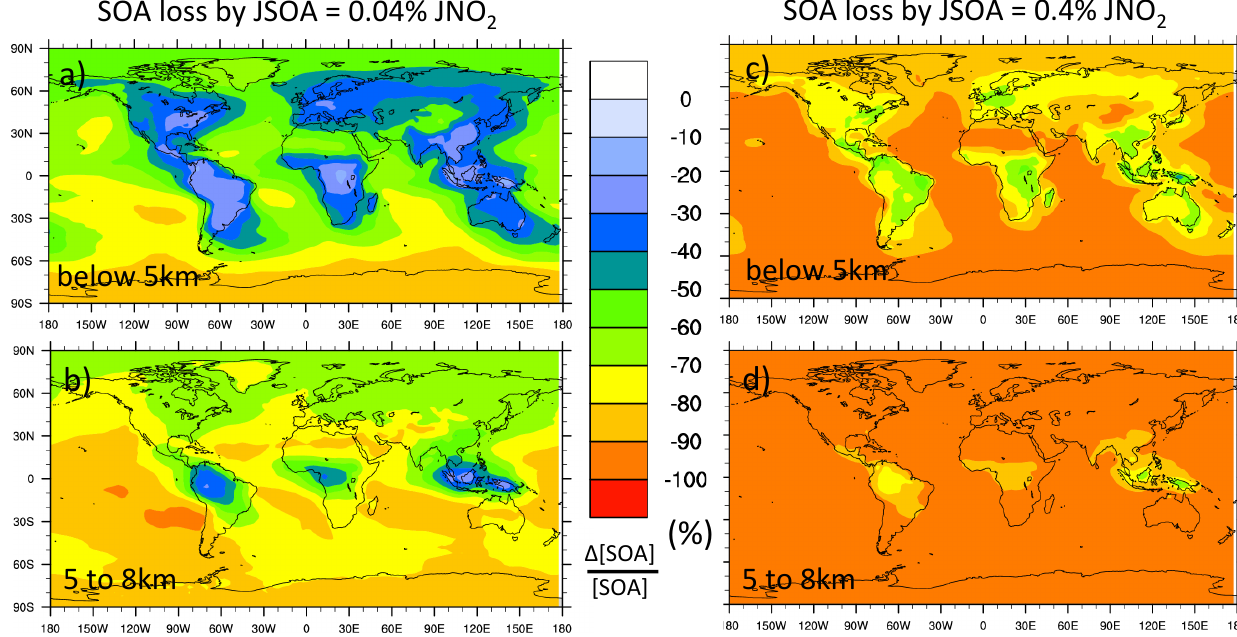
Figure 8. Relative reductions (%) in SOA concentrations due to particle-phase photolysis in the lower (a, c) and upper (b, d) troposphere. Two in-particle photolysis rates are considered, i.e., J SOA of 0.04% J NO